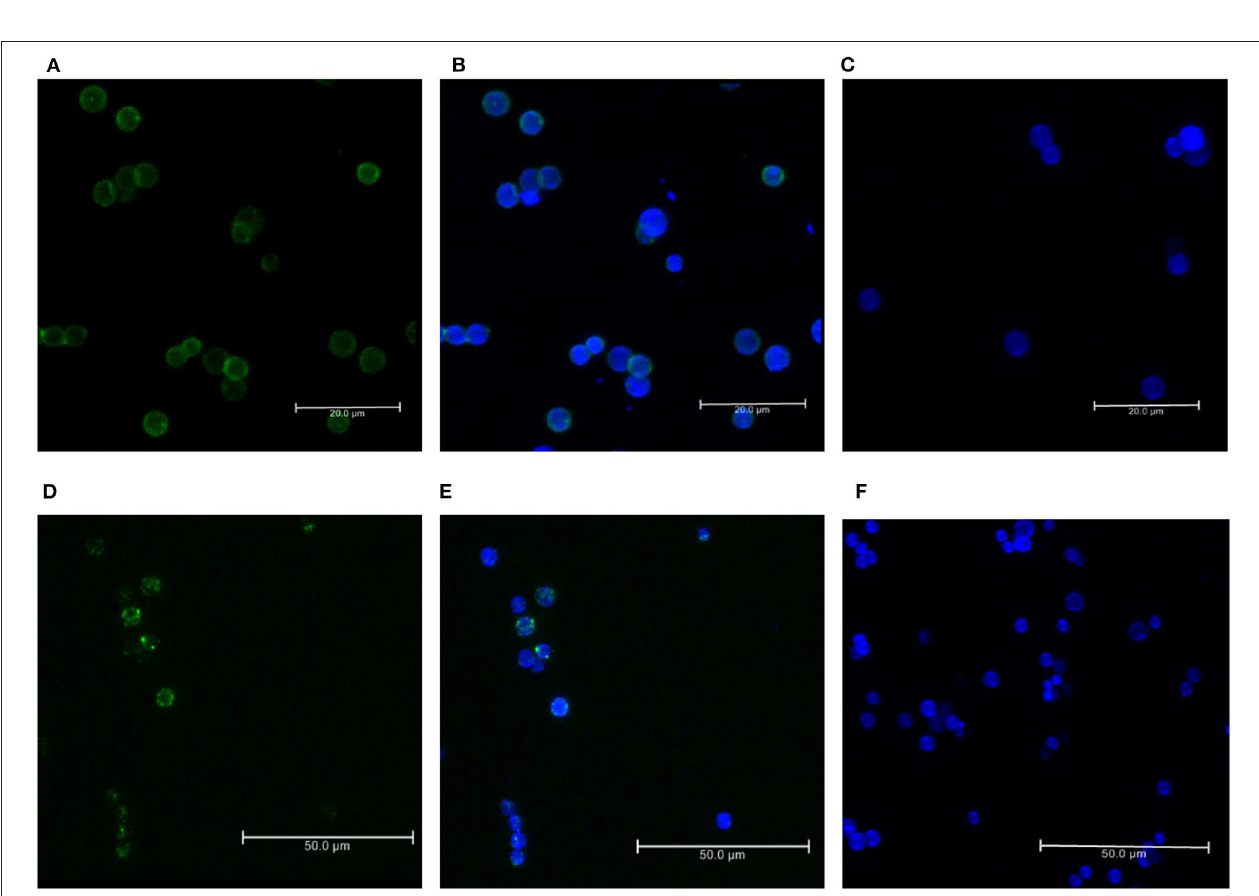
FIGURE 3 | Immunofluorescence of C3b and CFH binds to conidial surface. Binding of factor H and C3b to A. flavus conidia. Conidia were incubated with purified factor H and C3b separately and binding was visualized by immunofluorescence with rabbit anti-CFH antibody and an Alexa 488-coupled secondary antibody (green). The cell wall was stained with calcofluor (blue). (A) Immunofluorescence of conidia labeled with C3b (FITC-green). (B) Merged image of conidia labeled with C3b-FITC and calcofluor. (C) Negative control without the C3b. (D) Immunofluorescence of conidia labeled with CFH (FITC-green). (E) Merged image of conidia labeled with CFH-FITC and calcofluor. (F) Negative control without